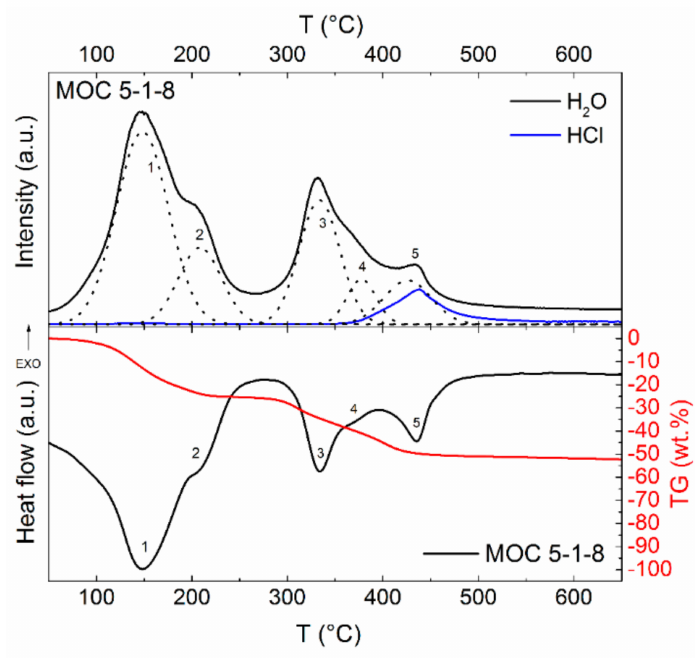
Figure 7. Simultaneous thermal analysis with mass spectroscopy of MOC 5-1-8 measured in inert